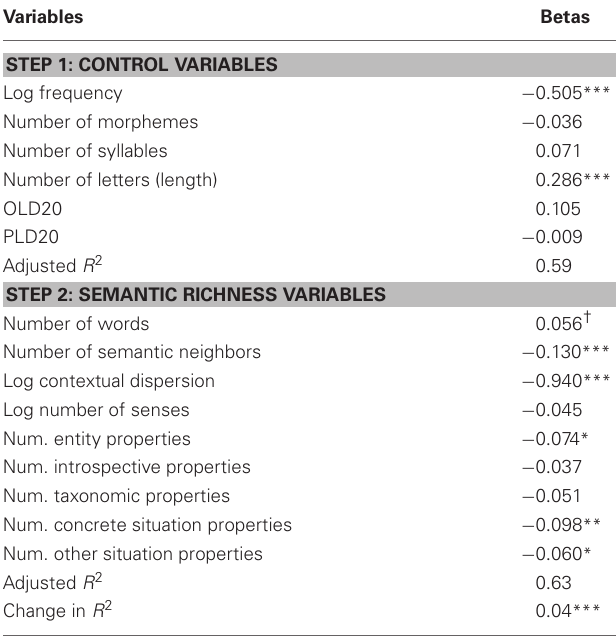
Table 7 | Standardized regression coefficients predicting lexical decision latencies, for all stimuli used in Analyses 1–2 that occur in the McRae et al. (2005) norms, using feature counts and codes from the McRae et al. (2005)